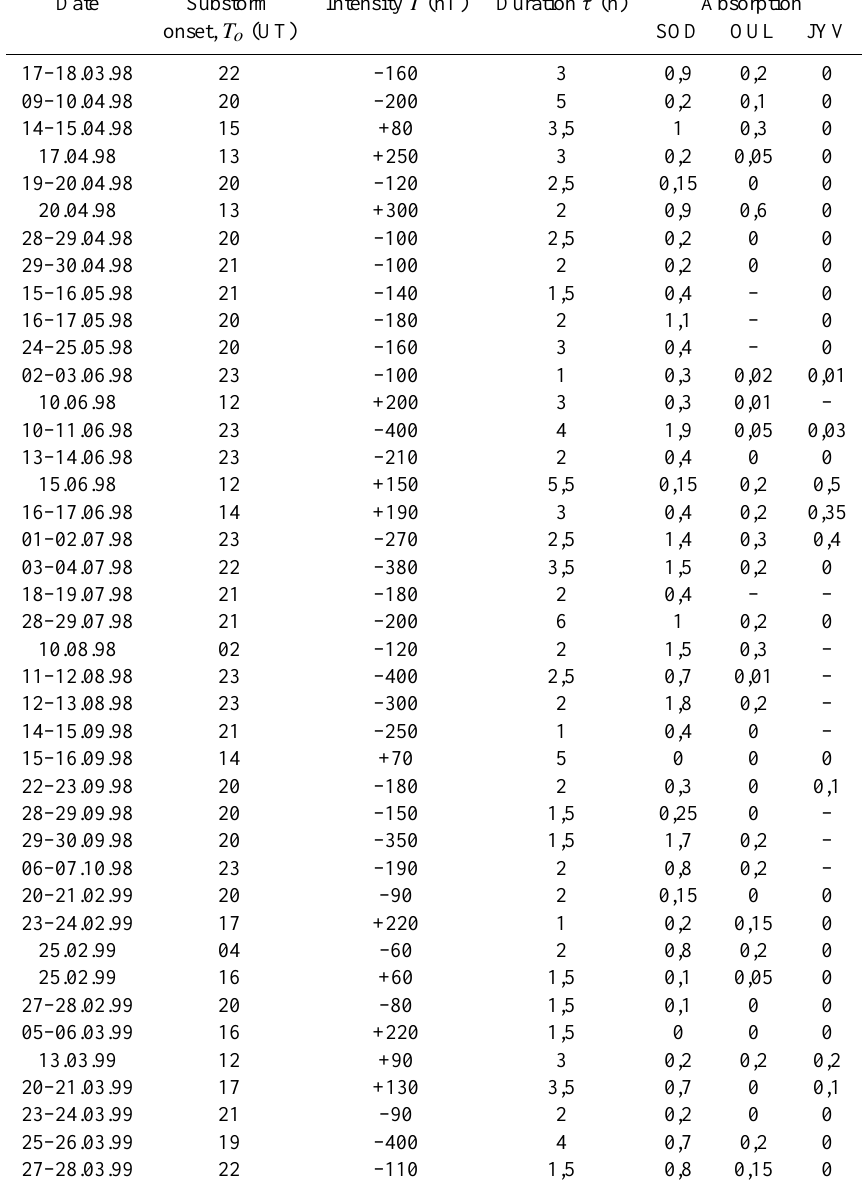
Table 1. Parameters of substorms by Sodankyla